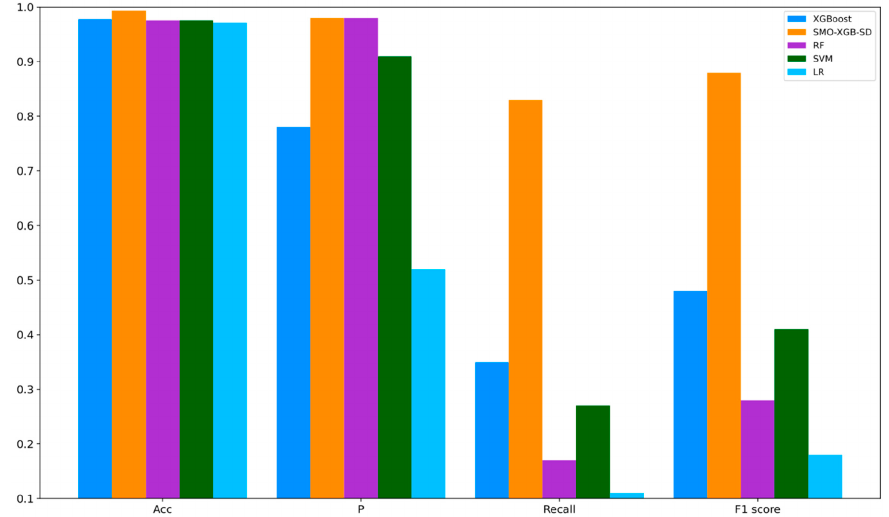
Table 4. Comparison results of SMO-XGB-SD, XGBoost, RF, SVM, and LR.